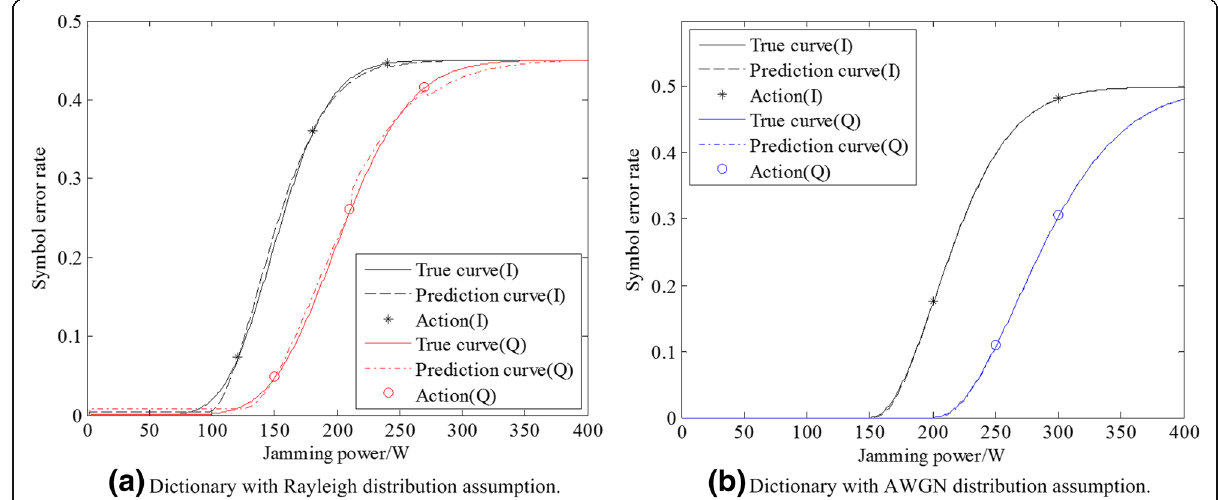
Fig. 7 Predicted results with the wrong dictionary. The jammer searched the value function with the wrong dictionary. a Dictionary with the Rayleigh distribution assumption but the real noise has an AWGN distribution. b Dictionary with the AWGN distribution assumption but the real noise has a Rayleigh